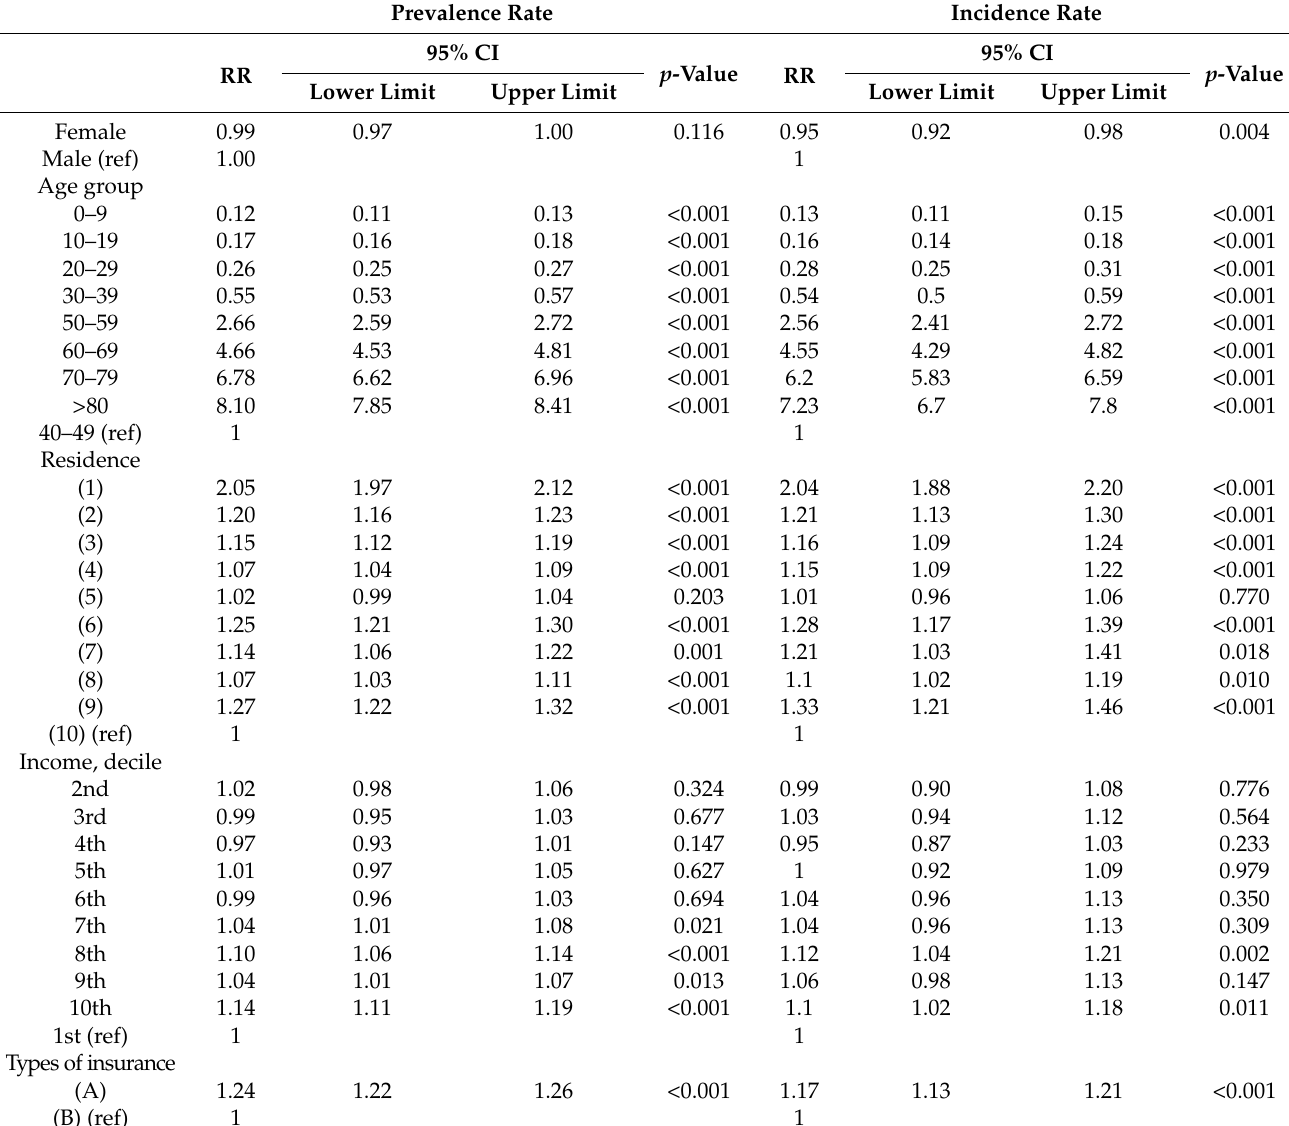
Table 1. Poisson regression to estimate the relative risk of annual prevalence and incidence rate of